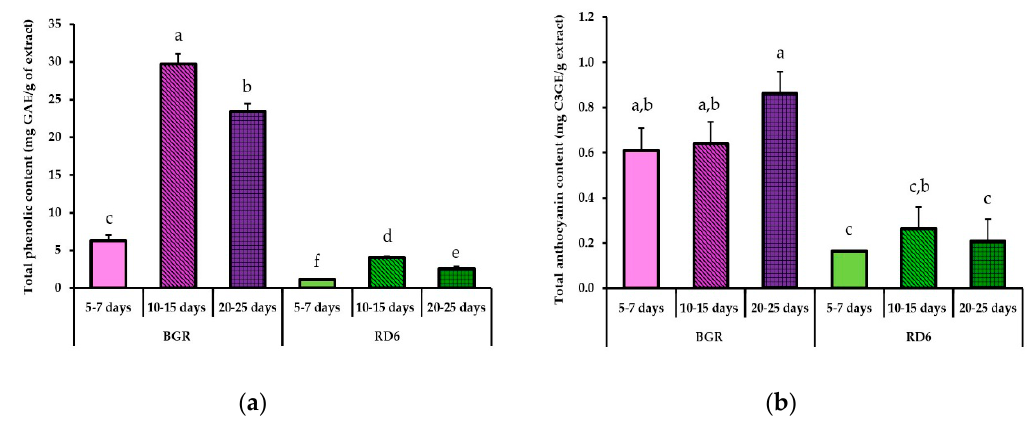
Figure 1. ( a ) Total phenolic content (TPC) of black glutinous rice (BGR) and RD6 according to Folin–Ciocalteu’s reagent methods. ( b ) Total monomeric anthocyanin content (TAC) of BGR and RD6 according to the pH differential methods. Results expressed as mean ± SD with four replicates for TPC and three replicates for TAC. The letters indicate statistically significant ( p < 0.05) among samples.